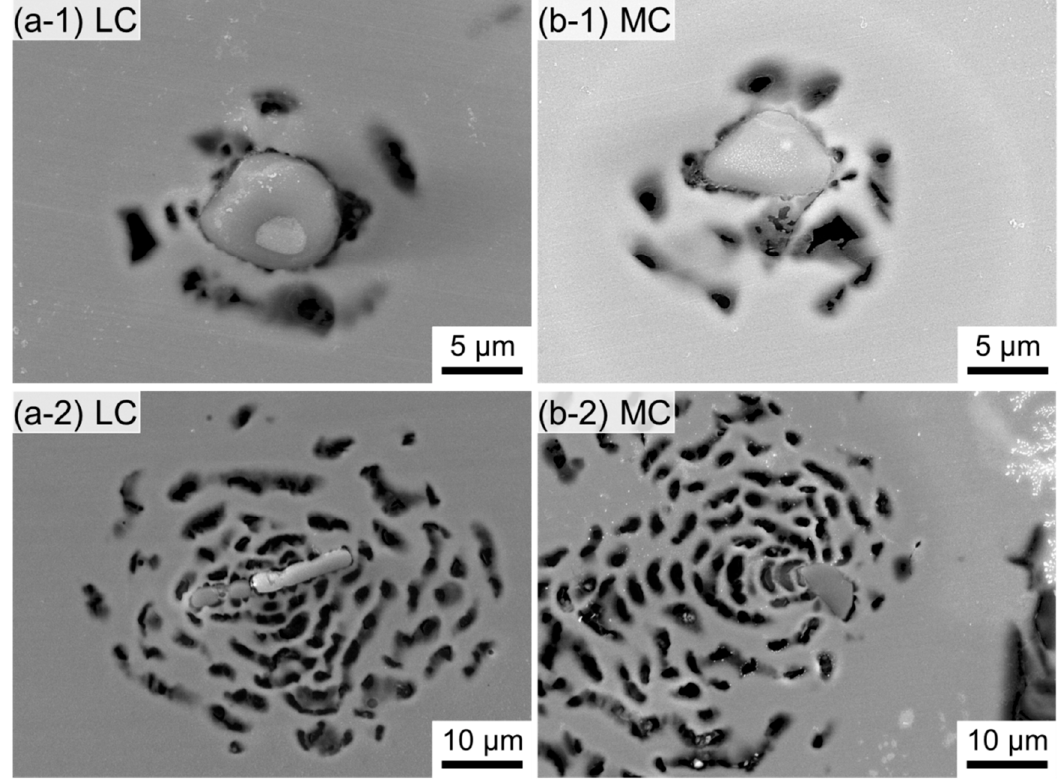
Figure 9. SEM images for pits formed in the ( a ) LC and ( b ) MC samples after potentiodynamic polarization in a 3.5 wt% NaCl solution. ( a-1 , b-1 ) Initiation and ( a-2 , b-2 ) propagation of pitting corrosion.